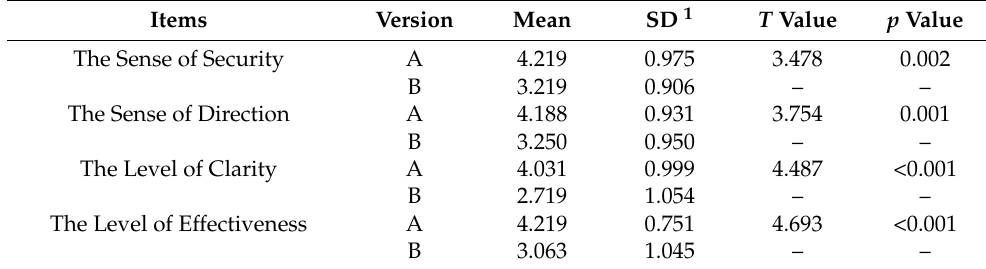
Table 3. The impression of navigation directives.